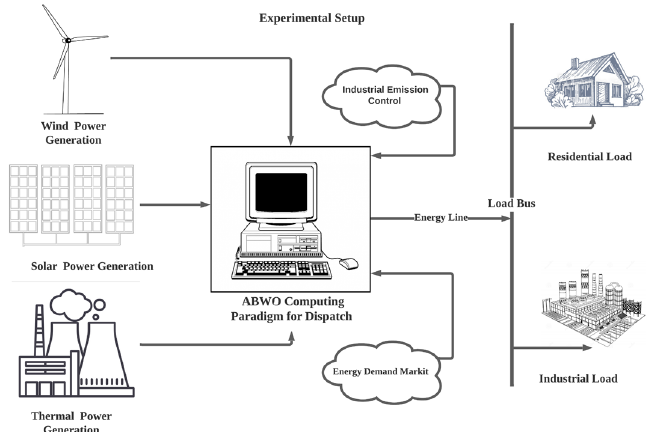
Figure 4. Generic experimental layout.